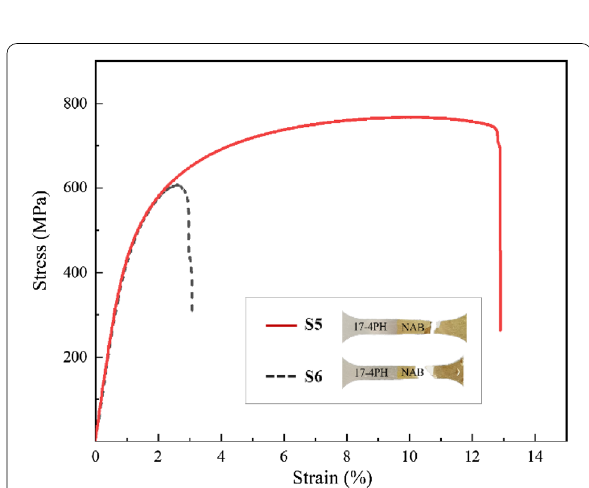
Figure 11 Tensile stress-strain curves for S5 and